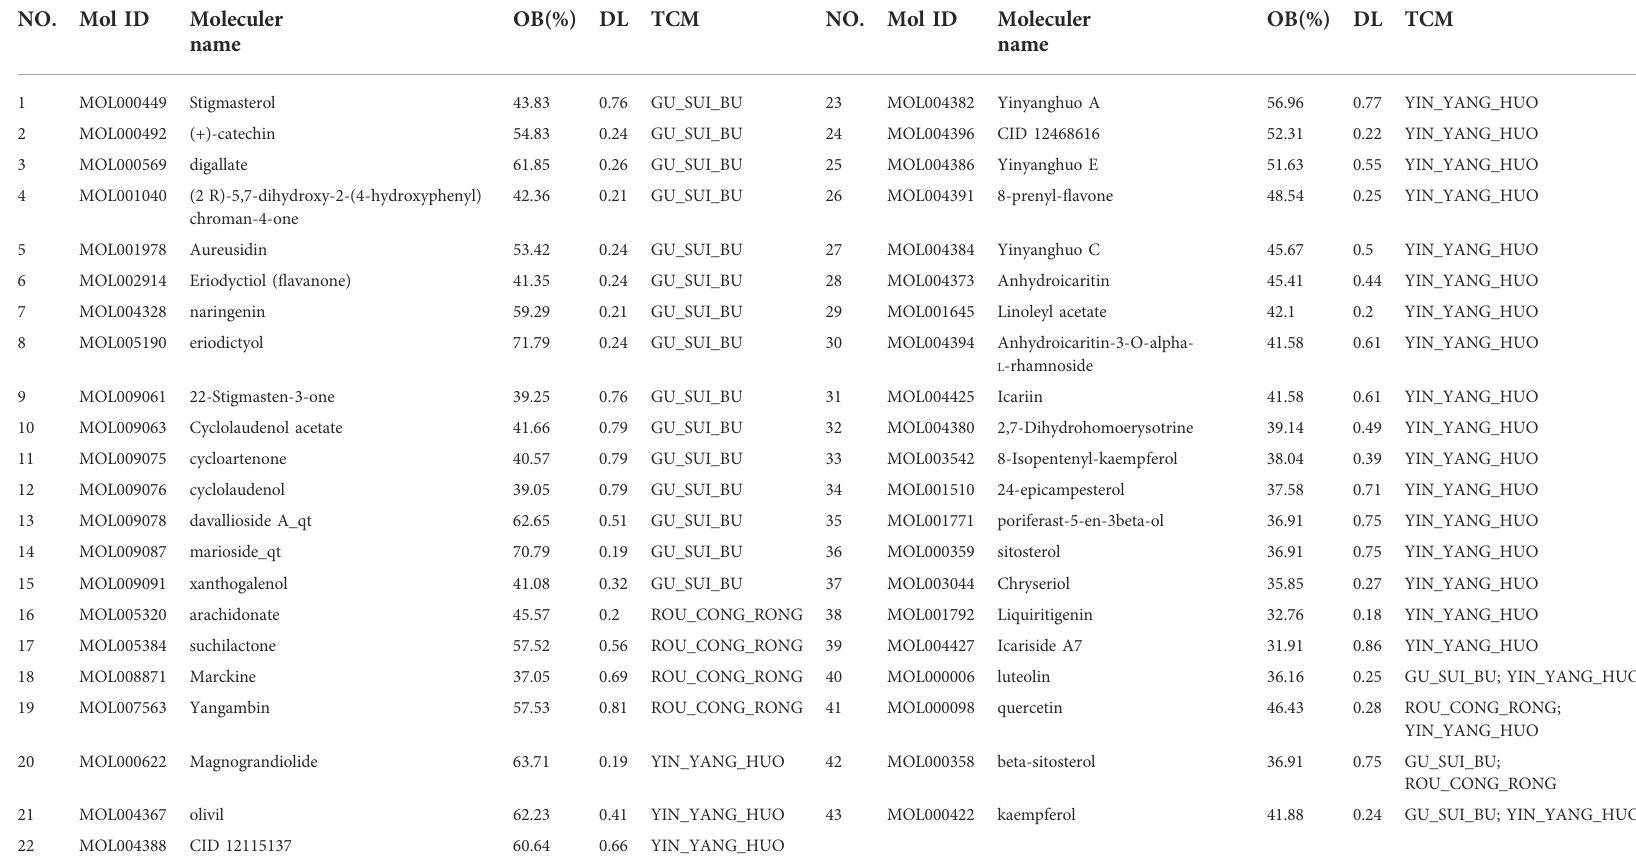
TABLE 1 Gusuibu, Roucongrong and Yinyanghuo compounds with oral bioavailability (OB) ≥ 30% and drug-likeness (DL) ≥ 0.18 from